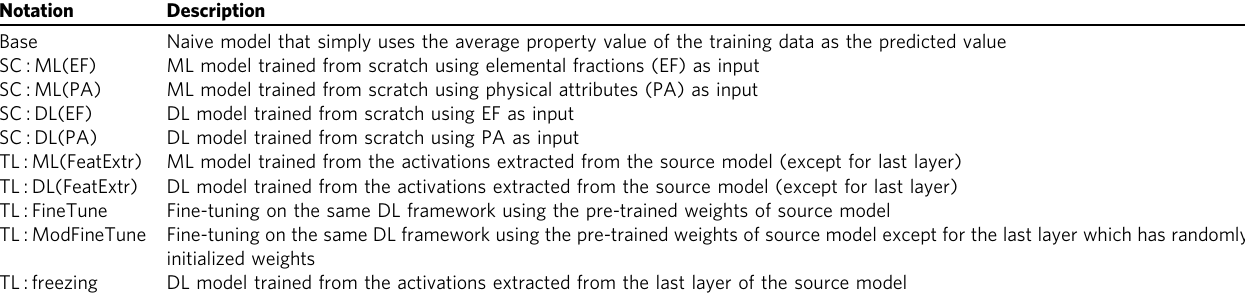
Table 1 Notations for the different scratch (SC) and transfer learning (TL) modeling con fi gurations used in this